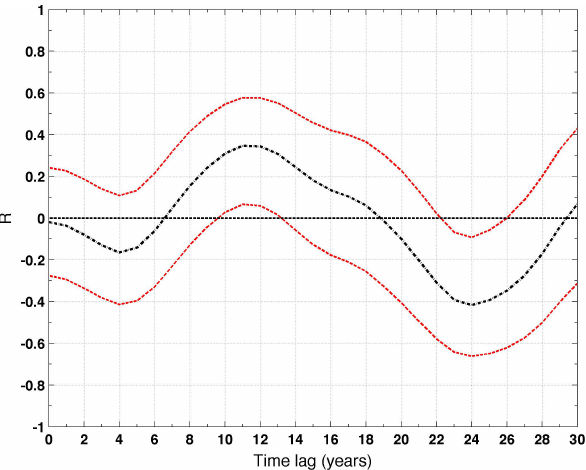
Fig. 5. Moving correlation between the Algero-Provenc¸al and Sicily Channel spatially averaged salinity data (for the averaging area see the Fig. 1). Dashed lines represent 95% confidence interval around the correlation